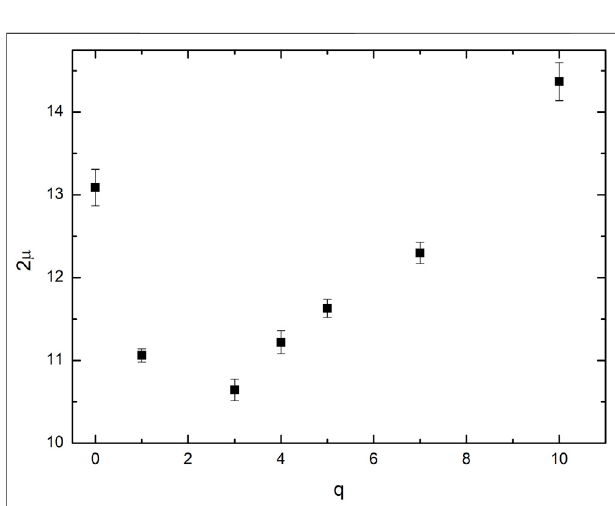
FIGURE 6 | The vortex-antivortex pair formation energy for different q .